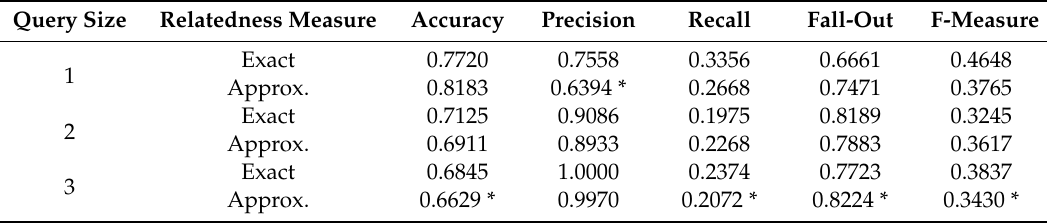
Table 2. Aggregated retrieval performance measures in classifications optimized for precision.